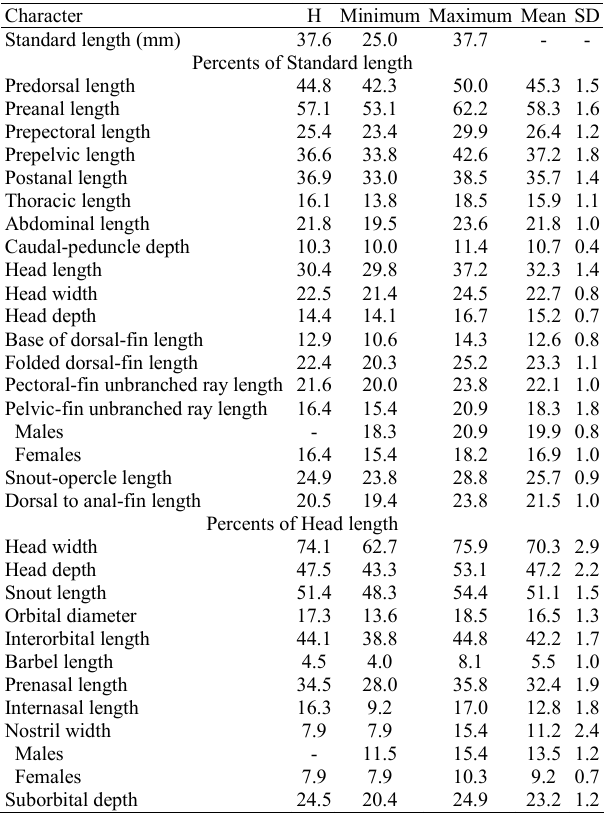
Table 1. Morphometric data for Microlepidogaster dimorpha . Holotype (H) and 30 paratypes, 16 females, and 14 males (DZSJRP 5564, 8750, 12332; MCP 45866; MNRJ 37848; MZUSP 107585); range includes holotype. SD = Standard deviation.